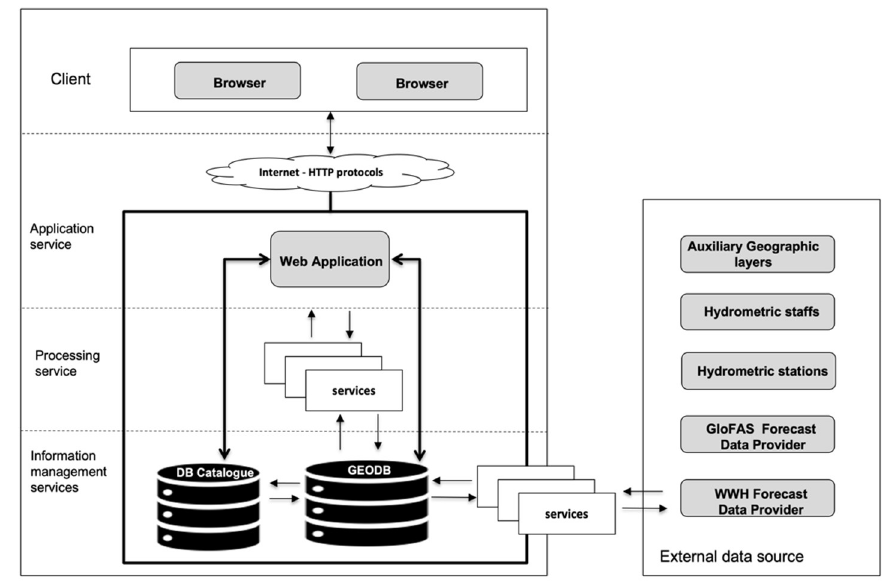
Figure 2. SLAPIS logical service-oriented architecture.